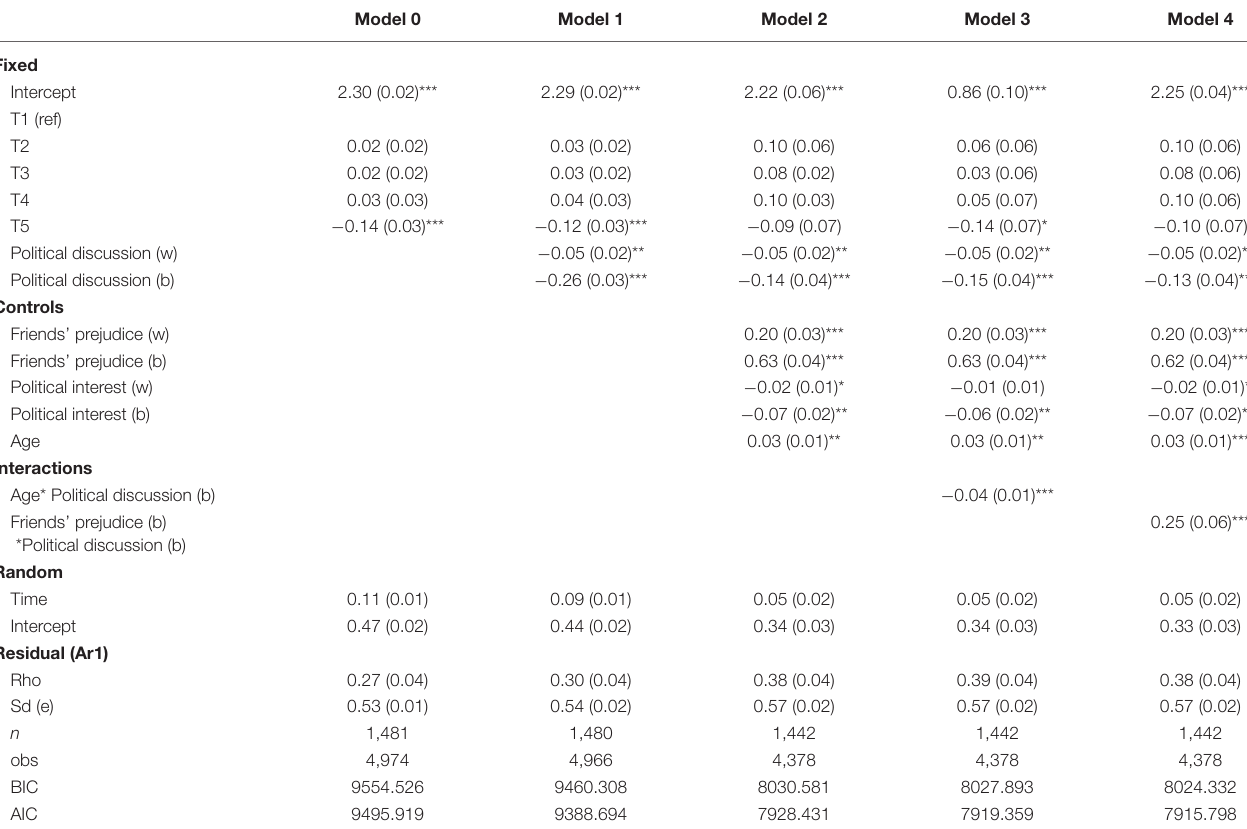
TABLE 1 | Political discussions and prejudice, linear mixed models with repeated measurements.